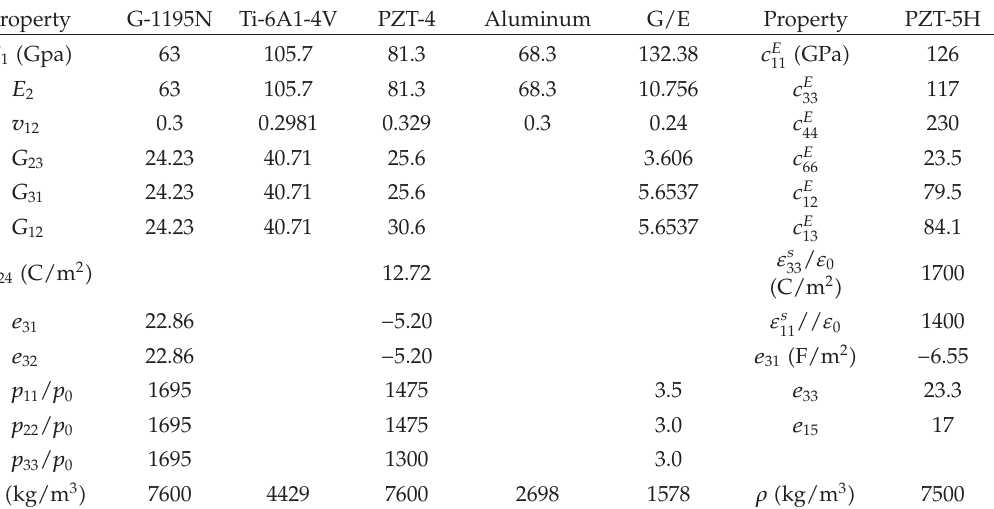
Table 1: Elastic, piezoelectric, and dielectric properties of the